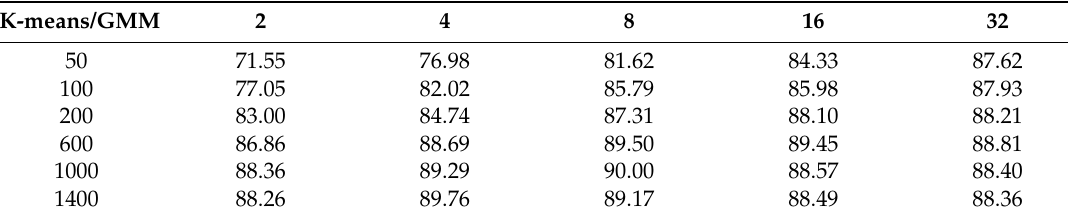
Table 2. Classification accuracy (%) of HCV with varying K-means/GMM codebook size on the LU database.